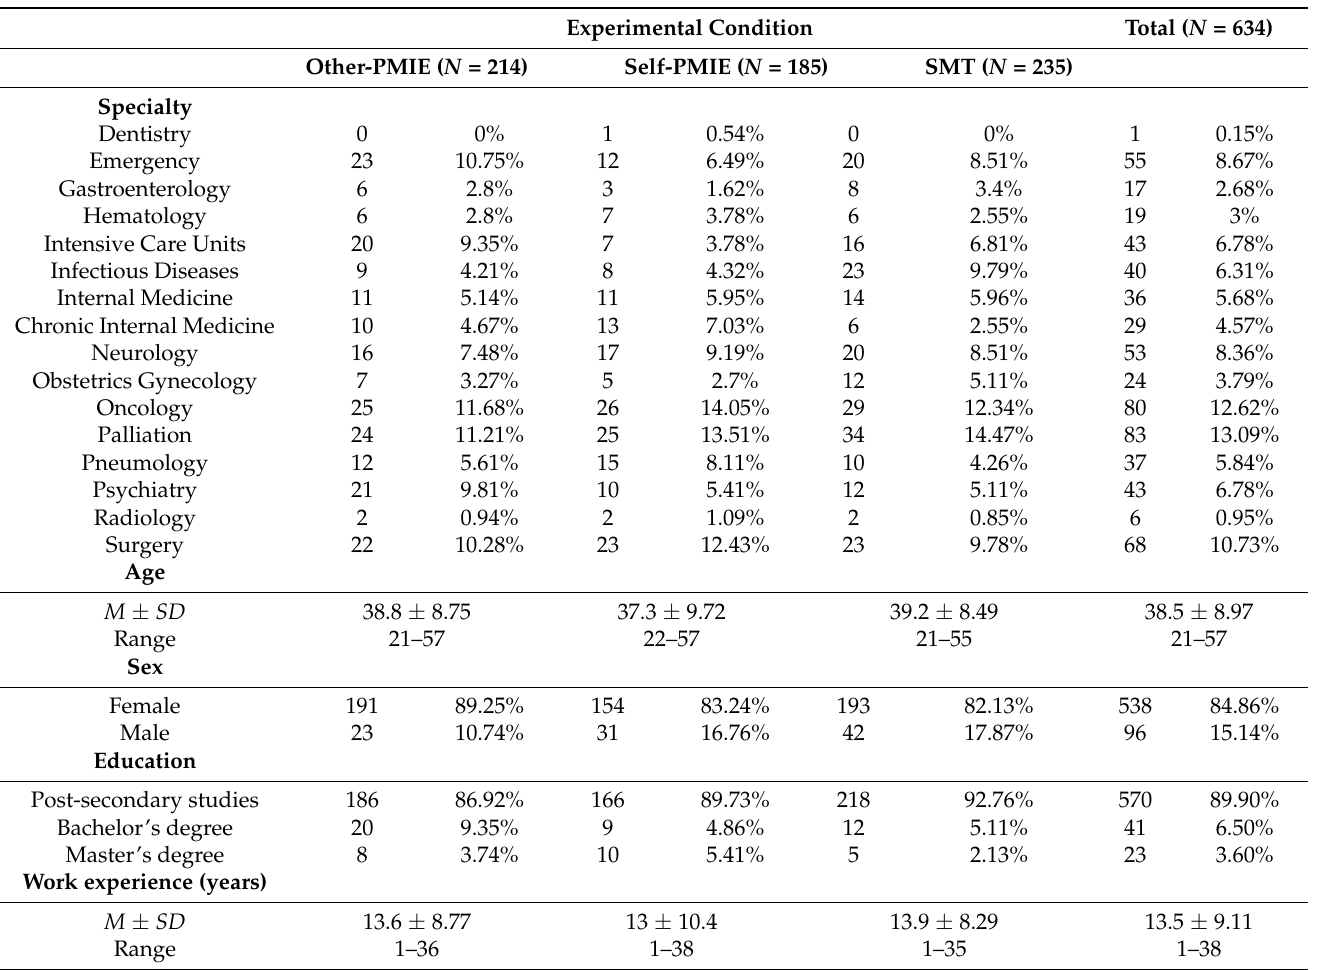
Table 1. Participants’